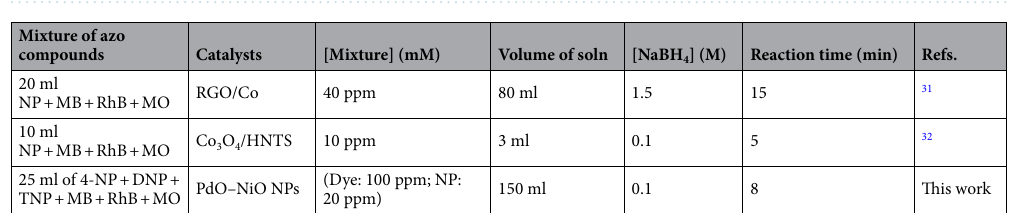
Table 2. Comparison of catalytic reduction performance of toxic azo compounds by various catalysts.